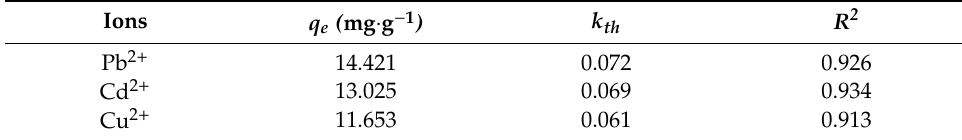
Figure S1: Photographs of SPM, Figure S2: EDS spectra of SPM after adsorb heavy metal ions (a-Pb, b-Cd, c-Cu, d-blank), Figure S3: E ff ect of pH value on the ion concentration, Table S1: The e ff ect of SPM on the initial concentration of the